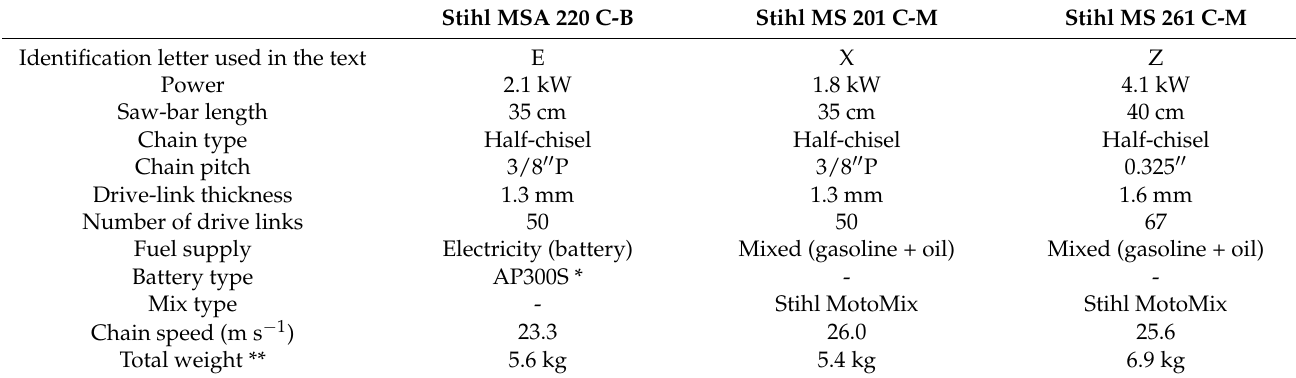
Table 1. Technical characteristics of the three chainsaws used in the